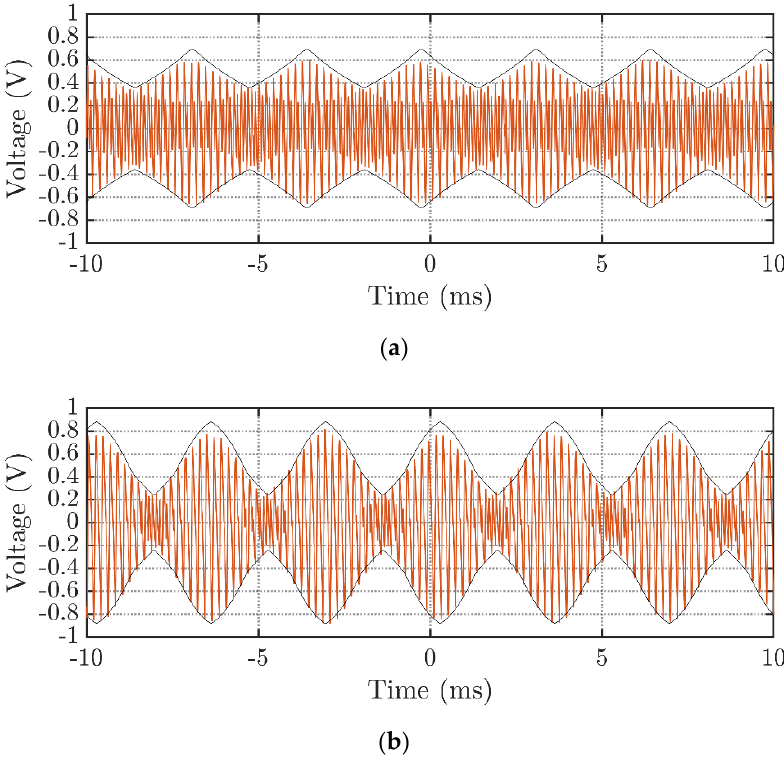
Figure 16. Dc link voltage switching ripple at: ( a ) m = 0.4; ( b ) m = 0.5.